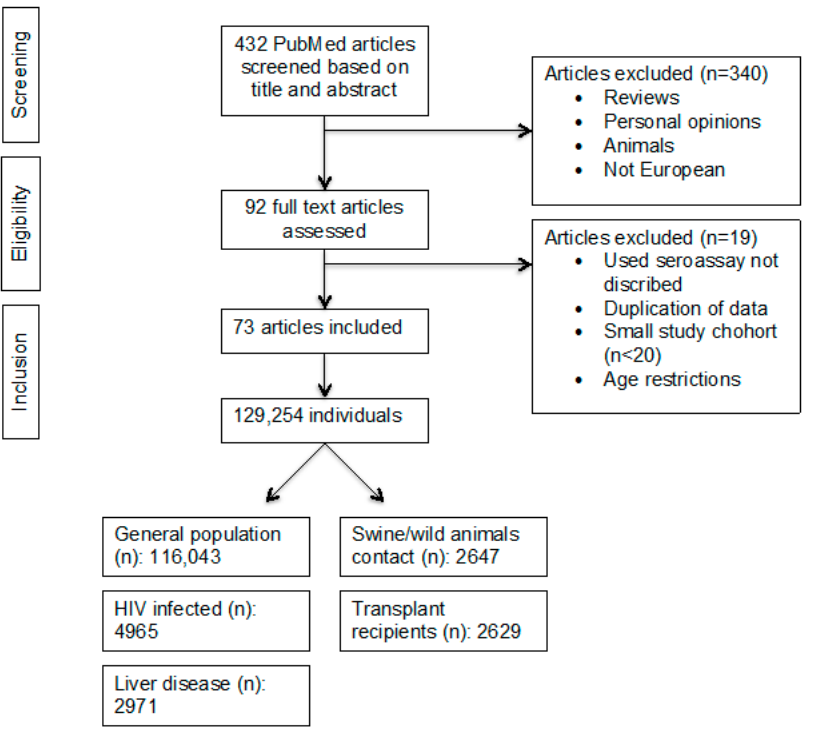
Figure 1. Search algorithm for the anti ‐ HEV IgG seroprevalence meta ‐ analysis.